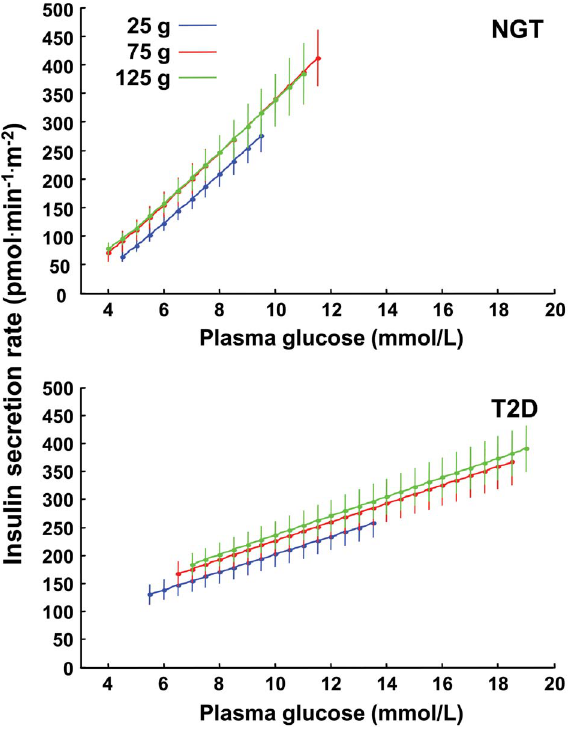
Figure 1. Beta-cell dose-response. Insulin secretion dose-response obtained from the IIGI at the three glucose doses in subjects with NGT subjects ( top ) and patients with T2D ( bottom ). Plots are mean 6 SE; glucose spans reflect the average observed levels.